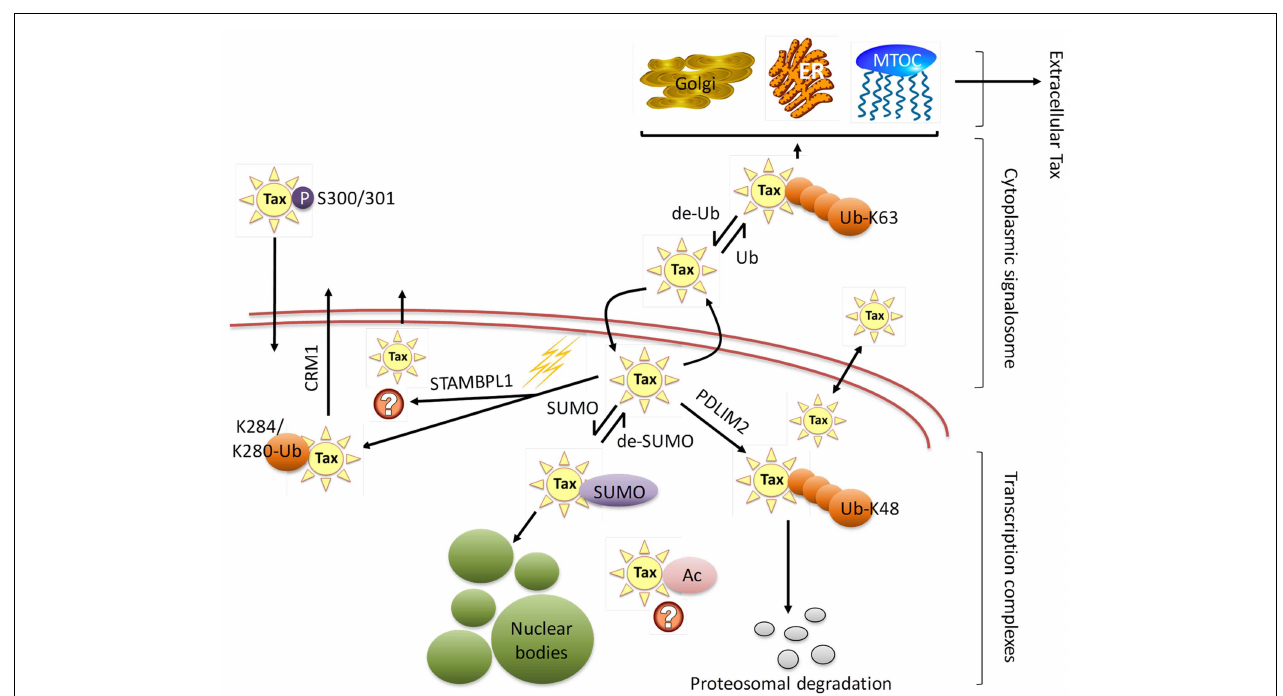
FIGURE 3 | HTLV-1Tax subcellular localization. HTLV-1Tax undergoes extensive post-translational modifications that regulateTax trafficking through the cytoplasm and nucleus, binding partners, and consequently its function.The figure showsTax translocation from nucleus to cytoplasm through a sumoylation/ubiquitination cycle. Cytoplasmic ubiquitinatedTax activates several signal transduction pathways and can be found in association with the endoplasmic reticulum (ER), Golgi apparatus, and microtubule organizing center (MTOC). Additionally, cytoplasmicTax can be secreted by extracellular